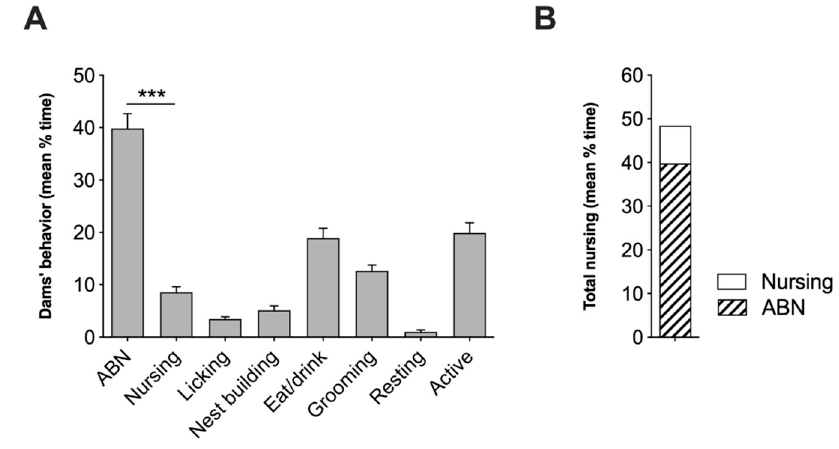
Figure 1. Spontaneous maternal behavior of CD1 foster dams. ( A ) Average percent time spent by CD1 foster dams in different behaviors and ( B ) total nursing during postnatal day 1–7. Data are presented as mean ± SEM. Statistical analysis was performed by using Wilcoxon signed rack test. *** p < 0.001.